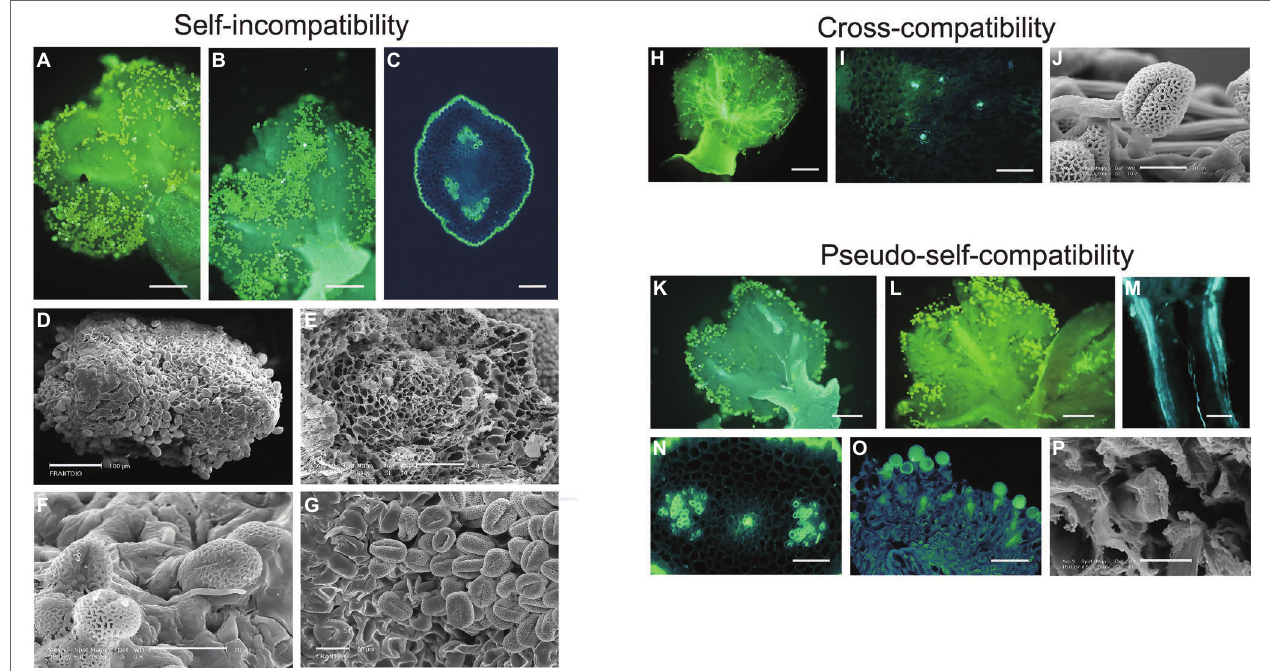
FIGURE 1 | Self-incompatibility, cross-compatibility, and pseudo-self-compatibility in olive. (A–G ) Self-incompatibility reaction in flowers of cultivars Frantoio, Leccino, and Dolce Agogia at 6 and 15 days after anthesis, as observed by epifluorescence images after aniline blue staining (A–C) and scanning electron microscope (SEM) images (D–G) . Pistils of cv. Frantoio (A,B) and transversal sections of style of cv. Leccino (C) and cv. Dolce Agogia (E) showing the absence of pollen tube growth in the style. Stigma of cv. Frantoio (D,G) and cv. Leccino (F) showing the absence of germinated pollen grains into the style. Bars = 150 μm (A,B) , 100 μm (D) , 50 μm (C,E) , and 20 μm (F,G) . (H–J) Cross-compatibility of cv. Frantoio (incompatibility group G1), pollinated with compatible G2 pollen, as observed by epifluorescence images after aniline blue staining (H,I) and SEM image (J) . Cross-pollination at 72 h after anthesis showing pollen-pistil compatibility (H) . Transversal section of style showing pollen tube growth throughout the pistil (I) . Stigma showing germinated pollen grains (J) . Bars = 150 μm (H) , 50 μm (I) , and 10 μm (J) . (K–P) : Pseudo-self-compatibility in self-pollinated flowers, as observed by epifluorescence images after aniline blue staining (K–O) and SEM image (P) . Flowers were collected at 6 (M–P) and 15 (K,L) days after anthesis. Pistils showing pollen tube growth in the style (K–M,O) . Transversal sections of style showing pollen tube growth through the stylar tissues ( N,P ). Bars = 150 μm (K–M) , 50 μm (N–O) , and 6 μm (P)